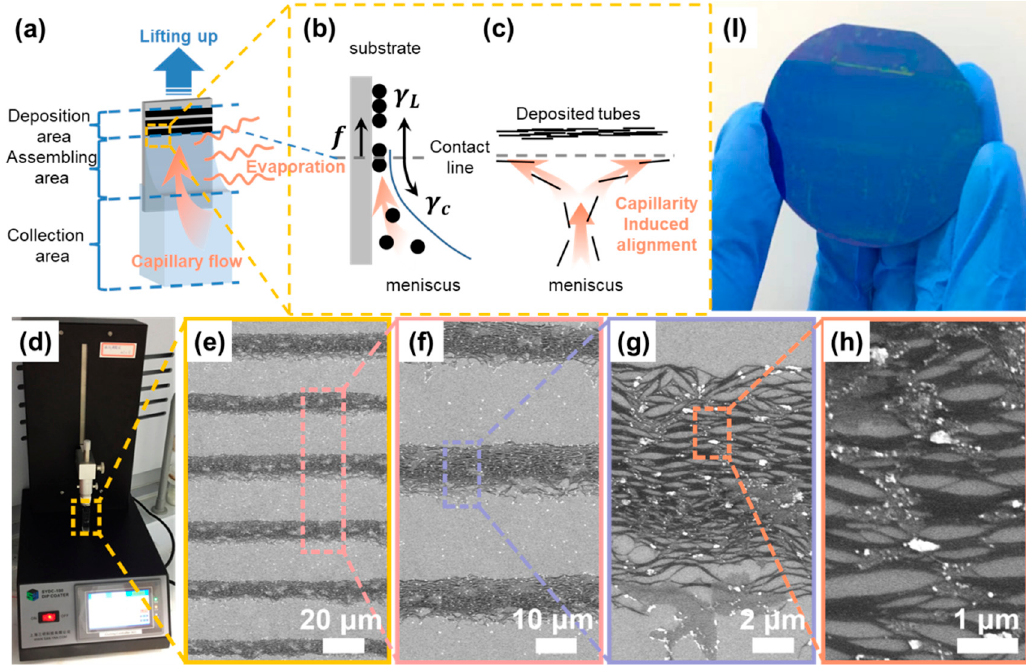
Figure 1. The dip-coating self-assembly fabrication of aligned SWCNT film. ( a ) Schematic of the coating process; ( b ) The deposition process driven by solvent evaporation; ( c ) The aligning process induced by capillary flow; ( d ) The experimental setup for the dip-coating processing; ( e – h ) SEM images for the deposited SWCNTs in different resolution (The regions in dark/light color refer to SWCNTs/substrate) and ( i ) as-deposited SWCNT film on a 2-inch wafer.